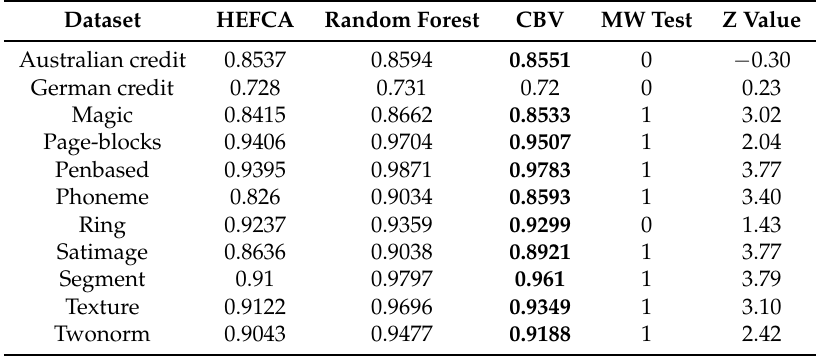
Table 5. Accuracy of HEFCA, Random Forest and